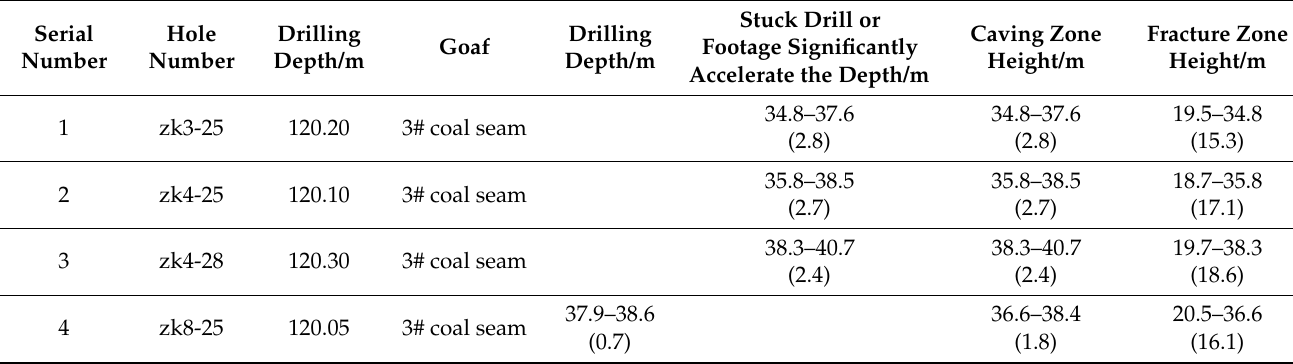
Table 3. List of the “three zones” in the 3# coal seam